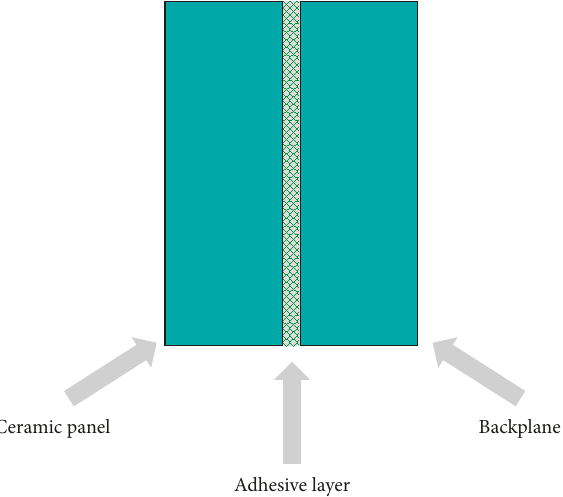
Figure 1: Schematic diagram of the ceramic